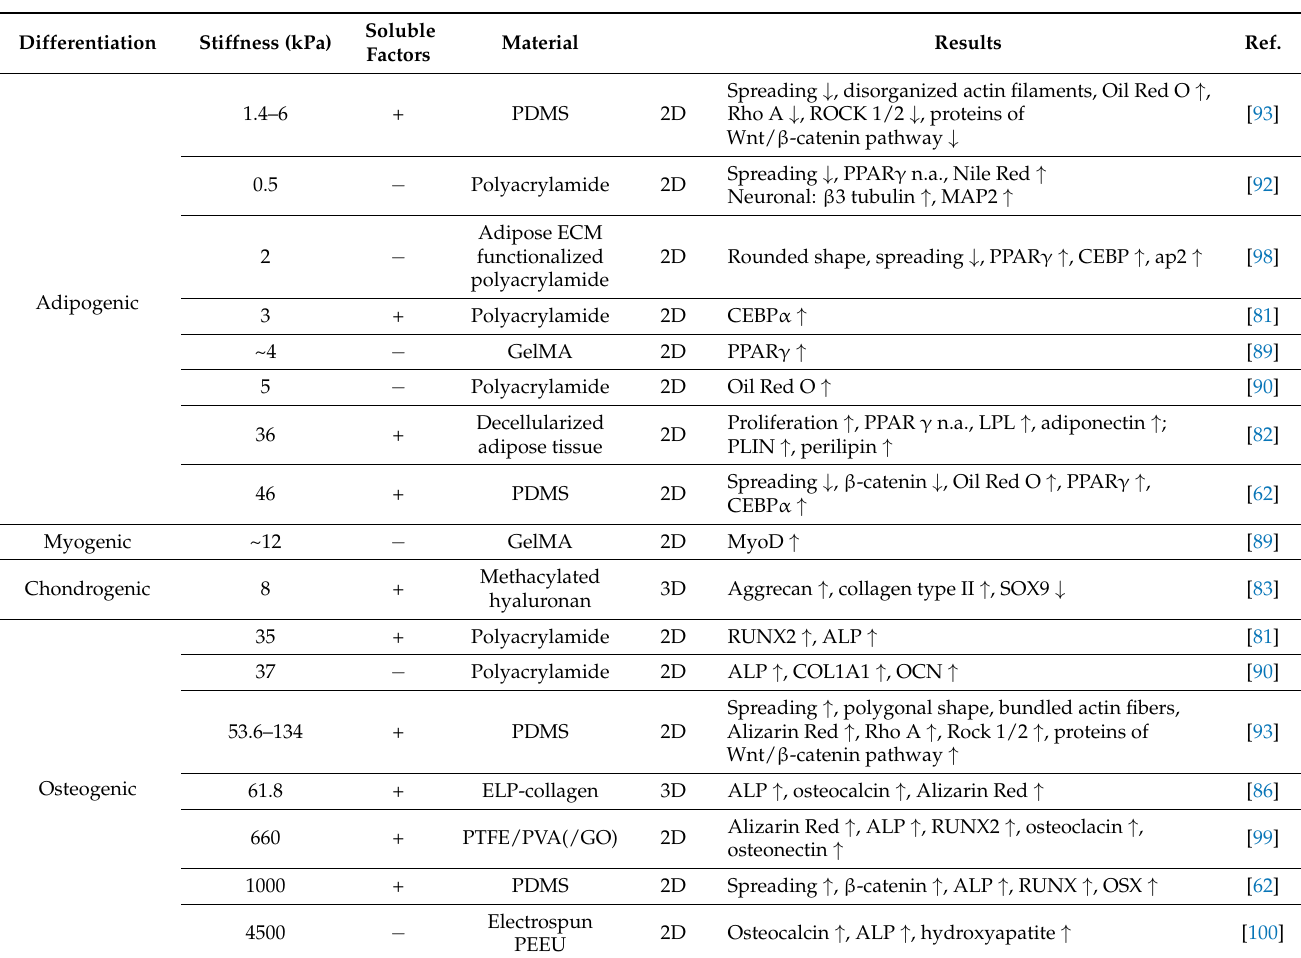
Table 1. Overview of the influence of substrate stiffness on ASC differentiation, adhesion, mor- phology, and proliferation. (PDMS: polydimethylsiloxane; ELP: elastin-like polypeptide; PTFE: polytetrafluoroethylene; PVA: polyvinyl alcohol; GO: graphene oxide; PEEU: polyetheresterurethane; ECM: extracellular